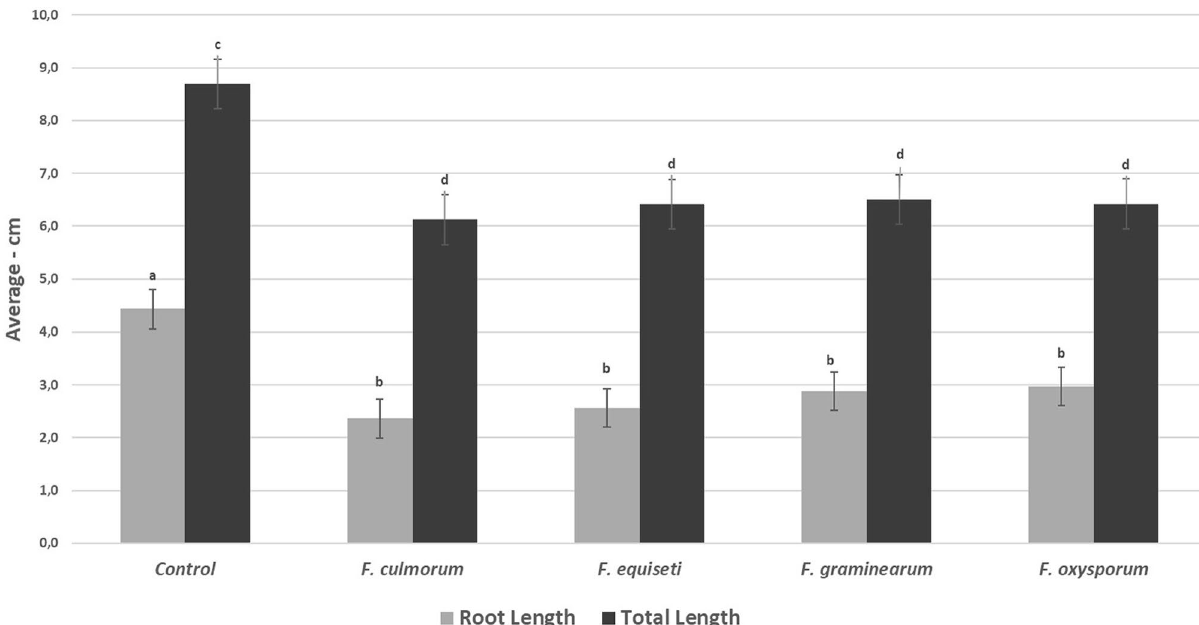
Figure 10. Average total length and root length of seedlings inoculated with Fusarium spp. under greenhouse conditions. The letters indicate significant differences between the control and the treatments (a, b) for root length and (c, d) for total length. The data are expressed as the mean with confidence interval using Student’s T-test ( p <